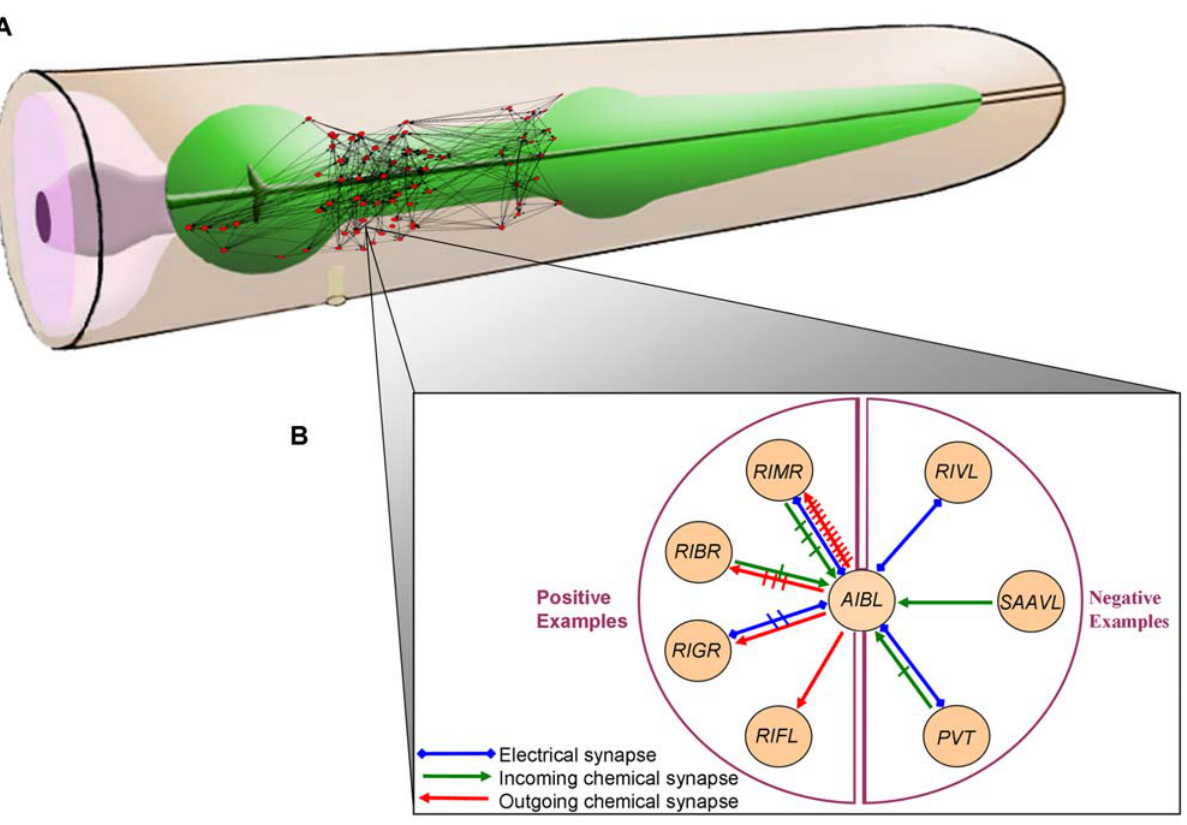
Figure 2. The Neural Network of the C.elegans Provides Examples for Learning the Patterns of Synaptic Wiring. (A) A standard schematic of the worm’s head (taken from Wormatlas [43]) with a network depiction of a part of C. elegans ’s neural network on the right side of the nerve ring. Neurons are in their real relative location (data taken from the authors of [44]). (B) An example of a neighborhood of one neuron. The neuron AIBL introduces all types of combinations of synaptic relations with other neurons. For each such combination one neuron has been chosen to demonstrate it. For example the neuron RIVL is the representative of the group of neurons that forms only electrical synapses with AIBL. Each cross on a synapse represents one more additional identical synapse that was observed. The neighborhood of a neuron is defined as the group of neurons that forms a synapse with it (chemical or electrical synapse in either direction). Neurons that are in the same neighborhood must be in spatial proximity in the worm’s body. A positive example is created when a neuron ‘‘chooses’’ to be presynaptic to another neuron in its neighborhood and a negative example is created when a neuron ‘‘chooses’’ not to be presynaptic to another neuron in its neighborhood.